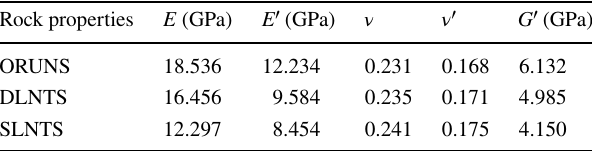
𝜈 is Poisson’s ratio in the transverse isotropic plane